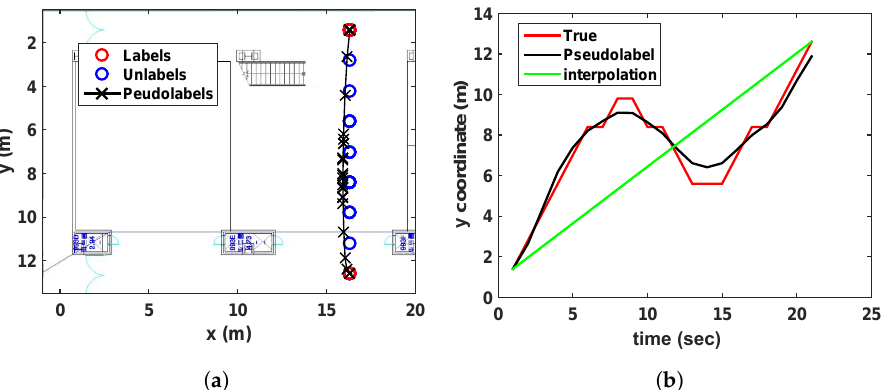
Figure 5. Estimated pseudolabels on the wandered trajectory in ( a ), in comparison with the linear interpolation in ( b